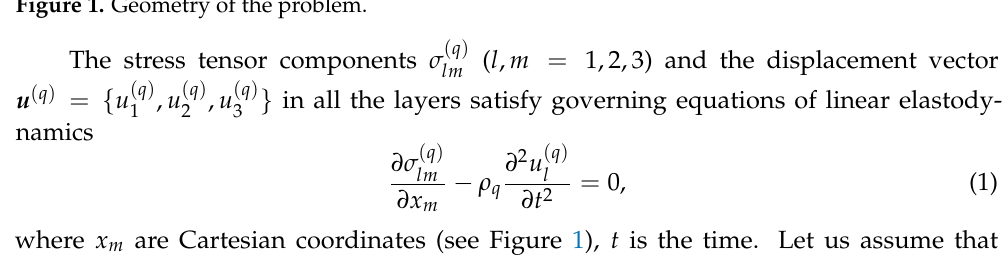
Figure 1. Geometry of the